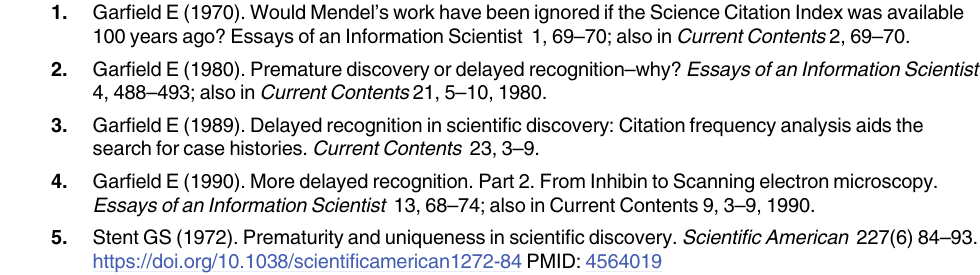
S6 Table. Number of SBs ( s = 10) for successive during-sleep citation-intensity intervals. S7 Table. Number of SBs ( s = 5) for awakening citation-intensity intervals. S8 Table. Number of SBs ( s = 10) for awakening citation-intensity